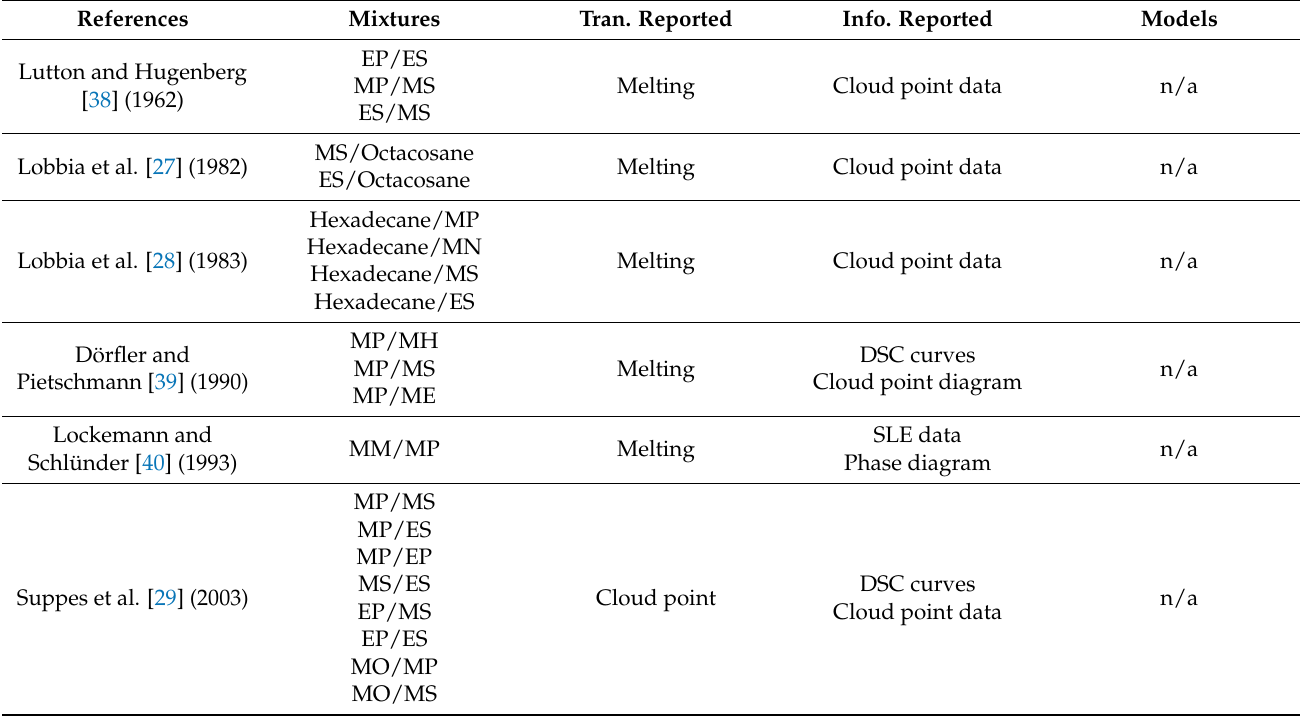
Table 1. Summary of the main information reported in all the references described in this paper. The meaning of the abbreviations used can be found in the section “Abbreviations” at the end of the article. All measurements are performed at atmospheric pressure, except in [37]. No common criteria are followed by all authors concerning which temperature defines the phase transition, so no generalization is done. Tran.